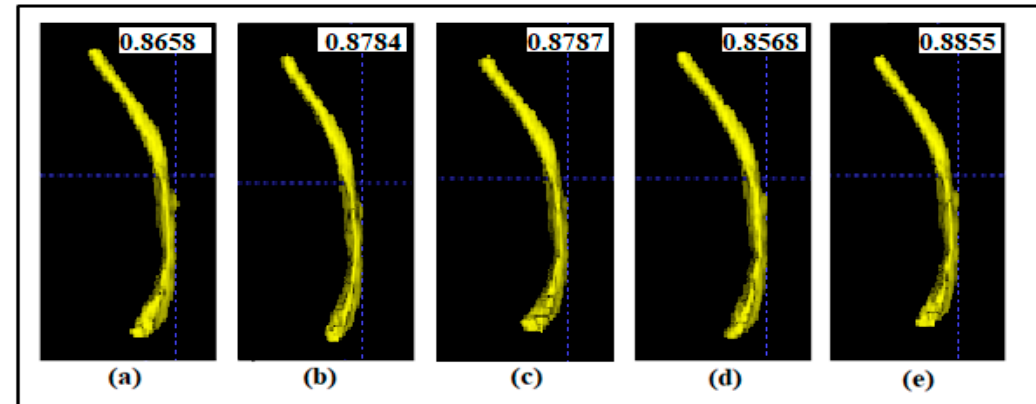
Figure 4. 3D visualization of esophagus segmentation results from patient 49th in the test set of SegTHOR dataset. The number indicates the Dice score, which was obtained from the organizer of the challenge. ( a ) Result from the weight of fold-1-trained; ( b ) Result from the weight of fold-2-trained. ( c ) Result from the weight of fold-3-trained. ( d ) Result from the weight of fold-4-trained. ( e ) Result from our method.